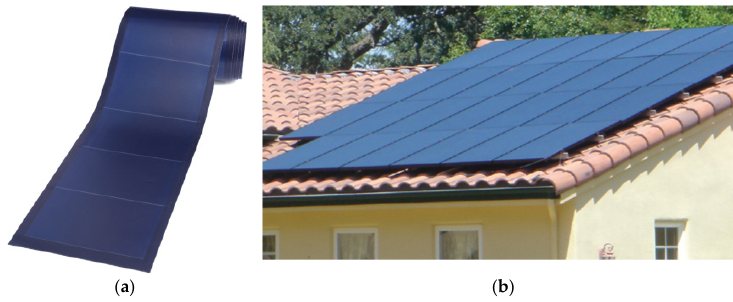
Figure 7. Example of BAPV products from Uni ‐ Solar ( a ) [29] and Hauptsitz ( b )